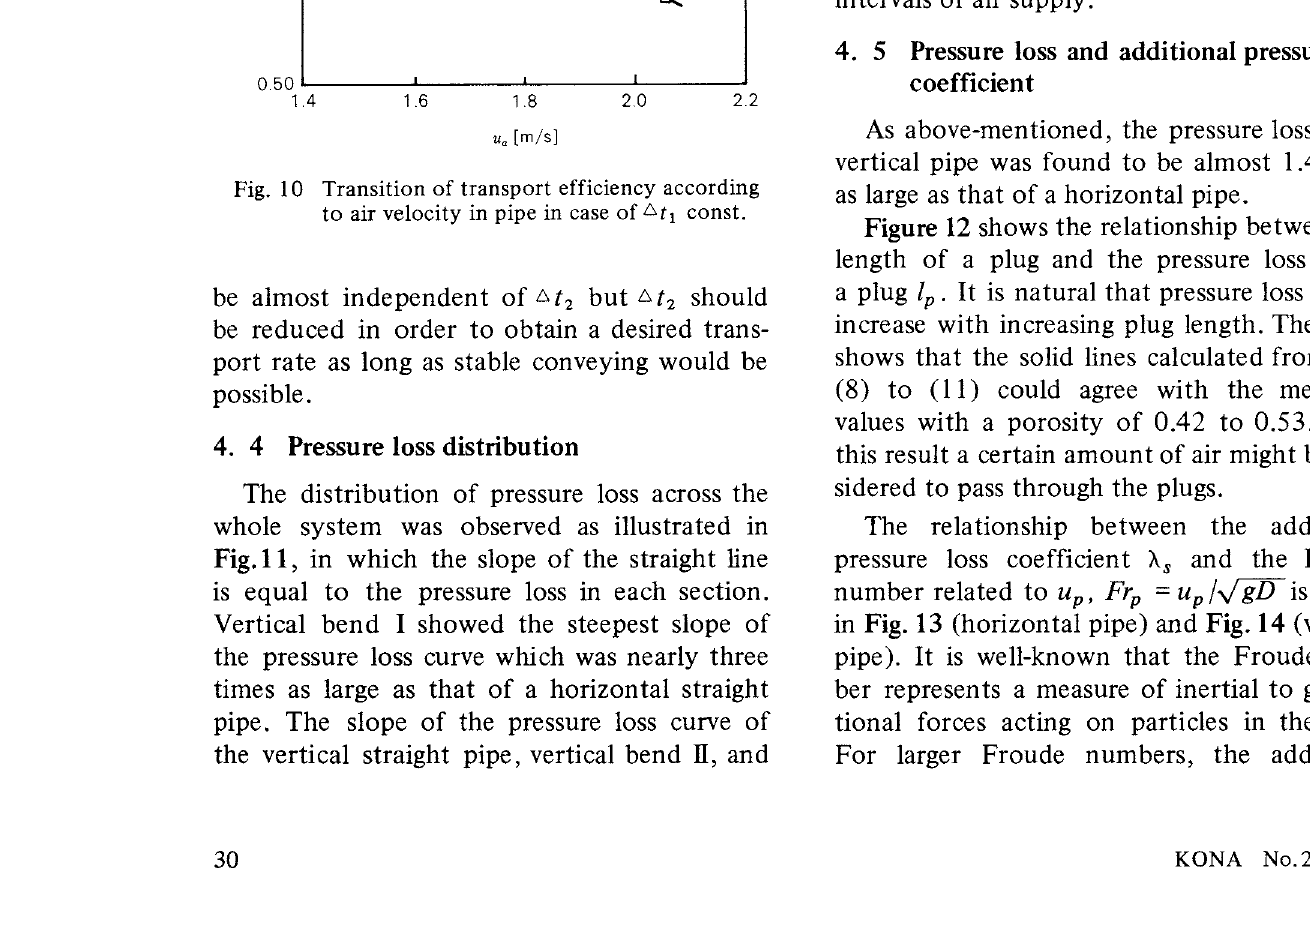
the horizontal bend pipe were almost 1.4